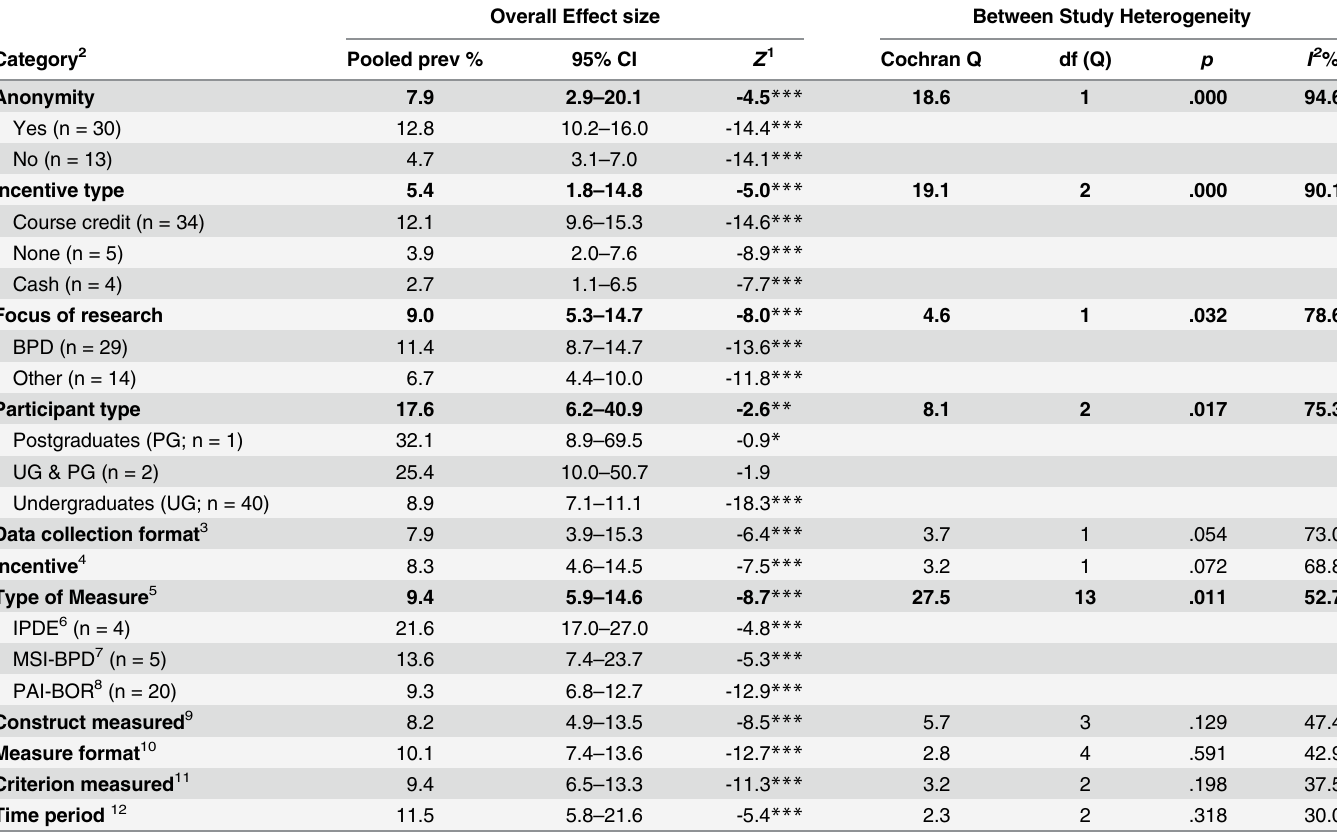
Table 1. Pooled Prevalence Estimates and Proportion of Variance Explained by Methodological Factors (N =